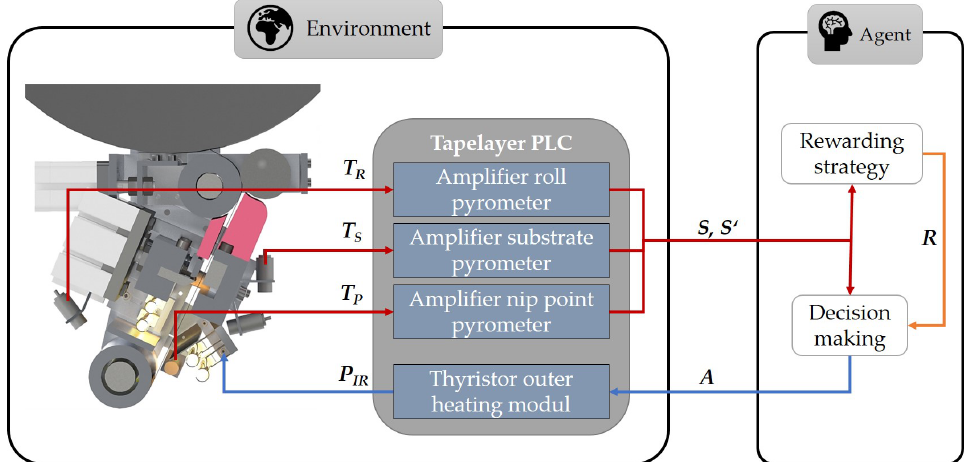
Figure 3. Structure of the control process supported by reinforcement learning algorithm.